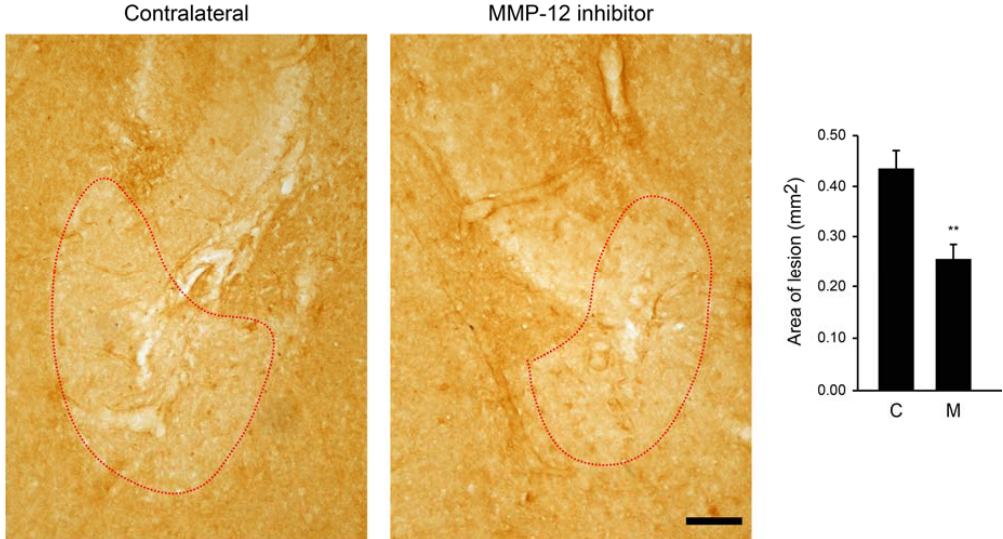
Figure 5. Effect of MMP ‐ 12 inhibition on Zonula Occludens ‐ 1 (ZO ‐ 1) labeling in the CA3 stratum lacunosum ‐ moleculare of rats after pilocarpine ‐ induced SE. Brain sections were stained again ZO ‐ 1, a marker of tight junctions. Interestingly, ZO ‐ 1 staining was absent in the ischemic lesion. The specific MMP ‐ 12 inhibitor induced a significant decrease of the lesion area (red ‐ dotted circle). Quantification = MMP ‐ 12 inhibitor. Data are shown as mean ± SEM. n = 7. ** p < 0.01; Student’s t ‐ test. Scale bar: 50 μ